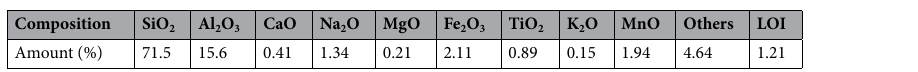
Table 2. Chemical composition of milled